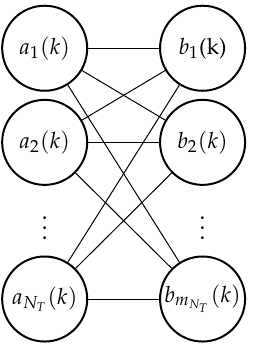
Figure 1. Bipartite graphical model formulation for data association at time k . The value assigned to a i ( k ) is an index to the measurement with which target i is hypothesized to be associated at time k and the value assigned to b j ( k ) is an index to the target with which measurement j is hypothesized to be associated at time k